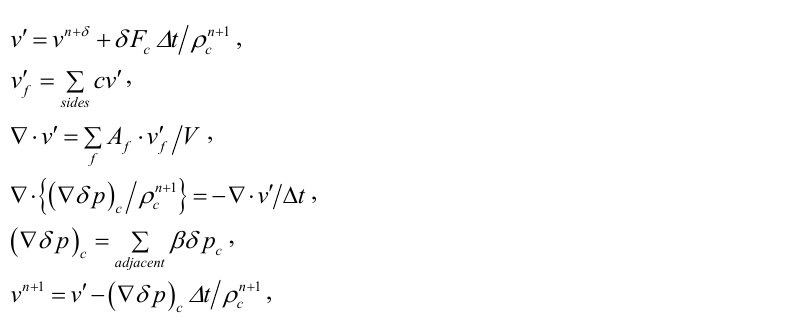
In our simulation algorithm, the intermediate velocity is obtained by the N-S equation which consists of the pressure and external force terms at time level n in addition to the unsteady, advection and diffusion terms. Then, the intermediate velocity is corrected by the SMAC algorithm (22) to satisfy the continuity condition at time level n + 1. In the SMAC algorithm, velocity-pressure coupling is achieved by the following